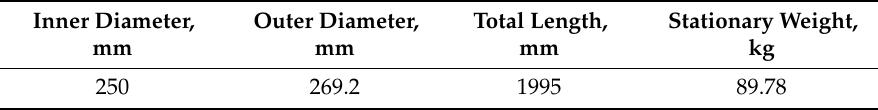
Table 2. Flexible piston accumulator prototype